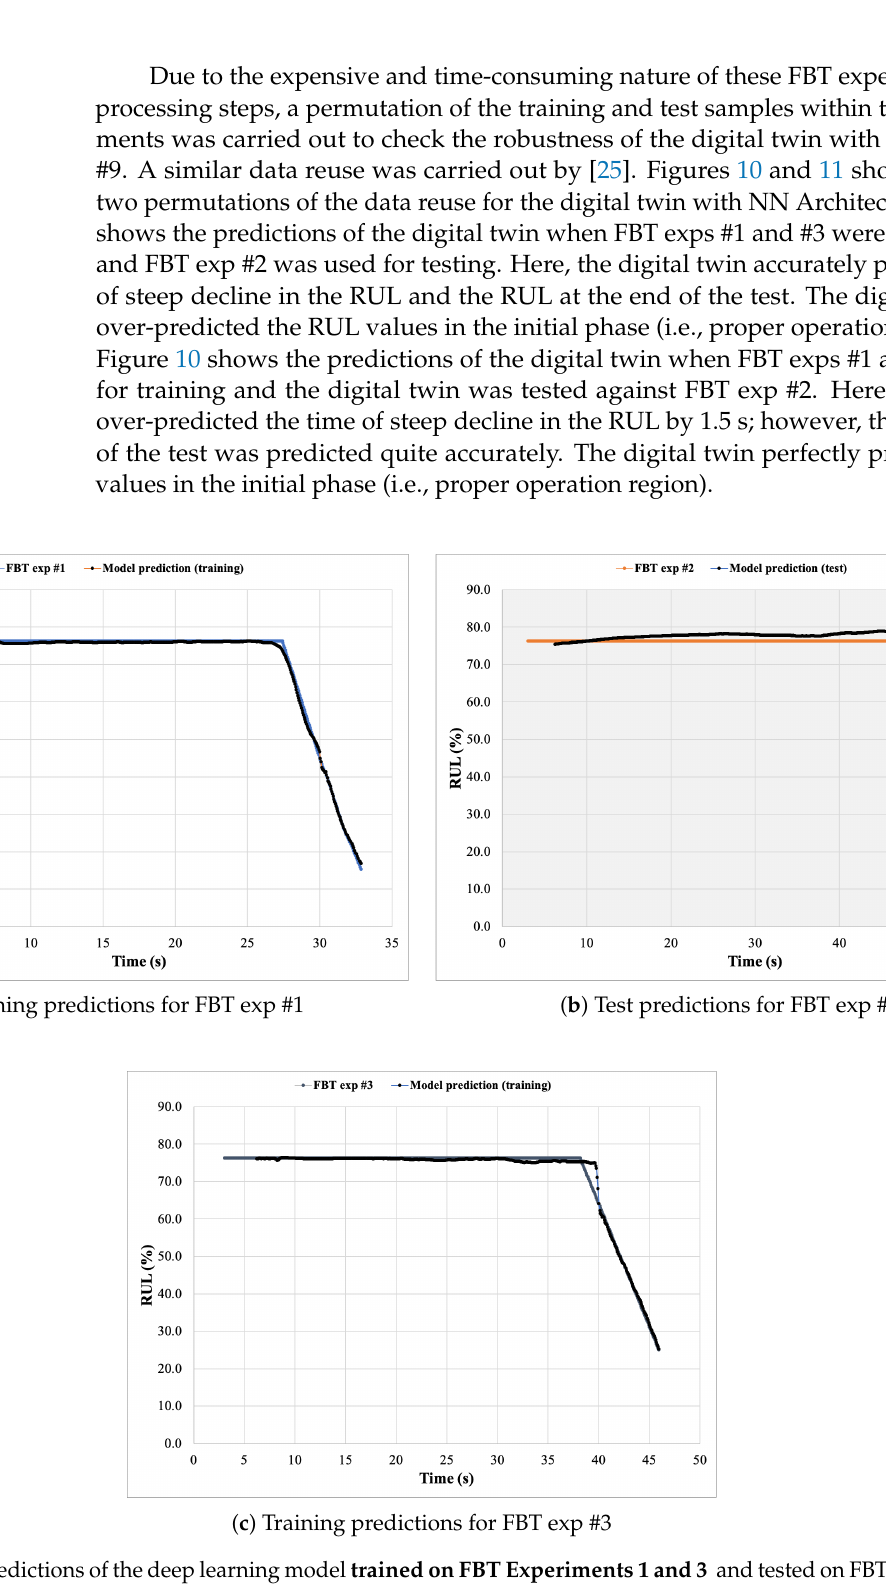
Figure 10. RUL predictions of the deep learning model trained on FBT Experiments 1 and 3 and tested on FBT Experiment 2. The gray background in ( b ) conveys that the digital twin was tested on this FBT